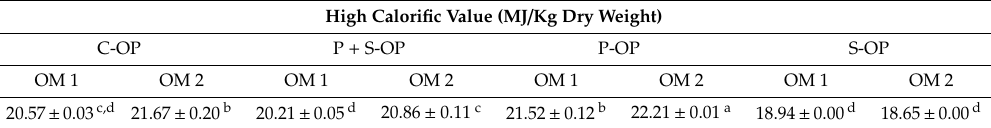
Table 4. Higher heating value (HHV) of crude olive pomace (C-OP) and olive pomace fractions produced after the wet and dry fractionation process (MJ / Kg